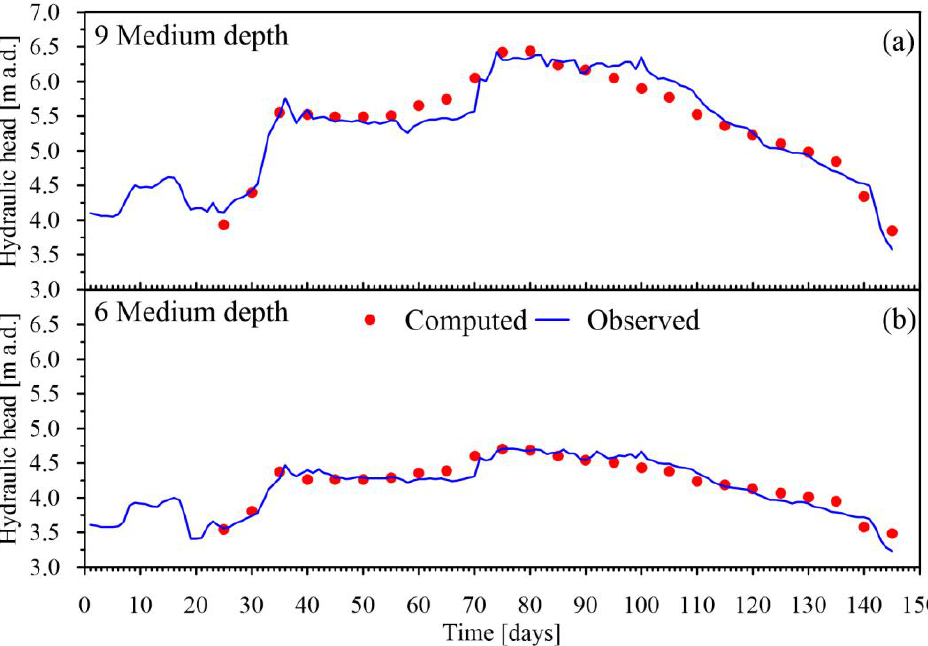
Figure 9. Observed and computed hydraulic heads above datum (a.d.) during the analyzed 145 days in two monitoring wells: ( a ) no. 9 ( b ) no. 6, both at medium depth. The location of the monitoring points is reported in Figure 2.